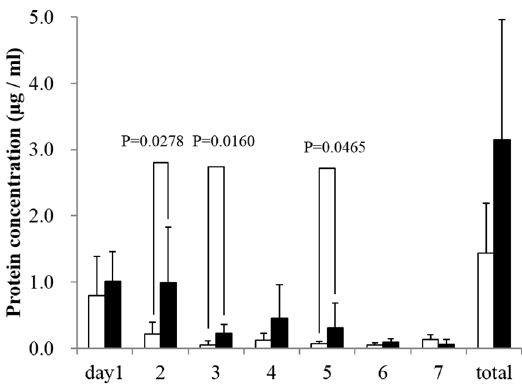
Figure 3. Qualitative rhBMP-2 released from scaffolds. Graph shows protein concentrations of retrieved supernatant of UDPHAp and IP-CHA groups. Mean values were compared using Mann-Whitney U test ( n = 5).